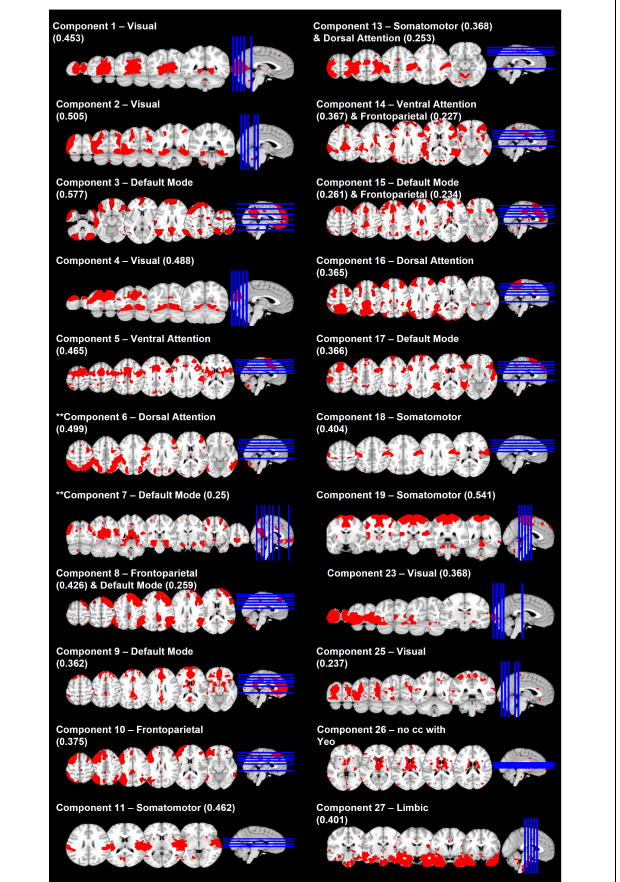
FIGURE 3 | Spatial maps of 22 selected network components. Network labels are based on cross-correlation with Yeo et al. (2011) and values in parentheses indicate the cross-correlation coefficient. ** denotes the two components whose connectivity was related to diagnostic status-by-memory accuracy